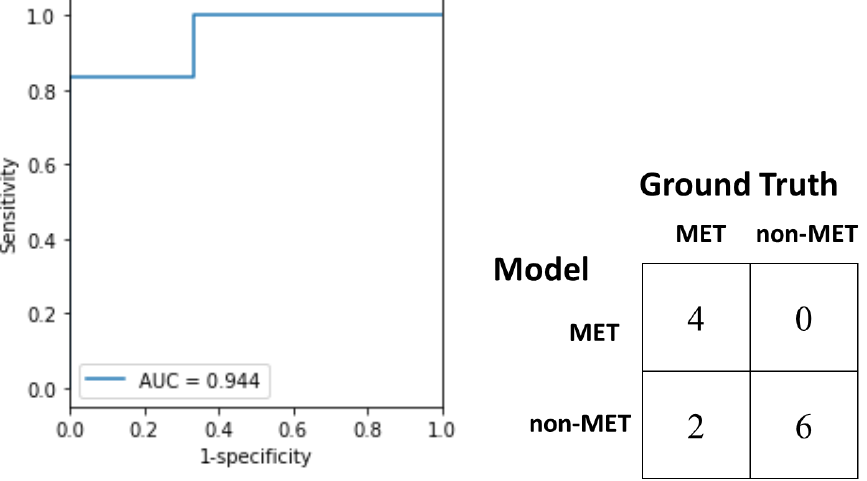
Figure 4. ROC curve and confusion matrix of the logistic regression model for identifying hepatocellular carcinoma (HCC) metastasis on the test set. Table 4. Performance of logistic regression, SVM and VGG16 on external validation set.